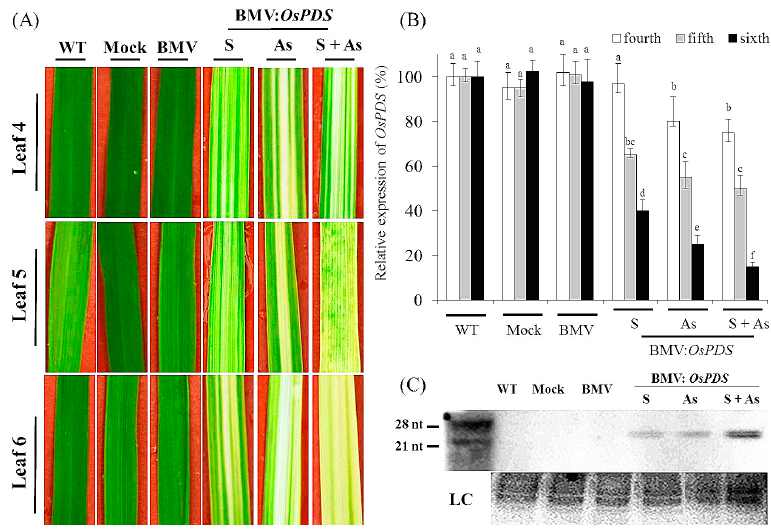
Figure 1. Silencing of phytoene desaturase ( PDS ) in rice CO-39 using the Brome mosaic virus (BMV)-induced gene silencing system. ( A ) Leaf 2 of 2-week-old rice CO-39 plants were inoculated with BMV carrying derivatives of recombinant RNA3 vector expressing gene segments of OsPDS